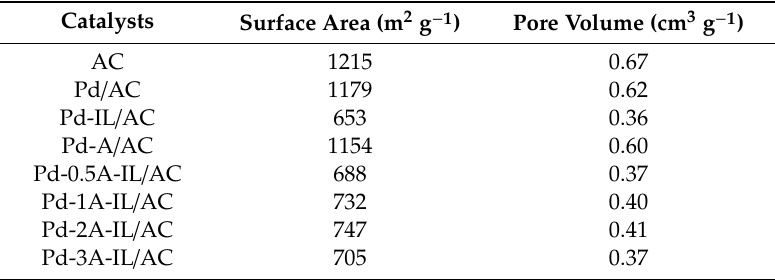
Figure 3. Characterization of fresh and used Pd-A-IL / AC catalysts. ( a ) XRD patterns. ( b ) XPS spectra. HAADF-STEM and EDS Mappings of ( c ) fresh and ( d ) used Pd-2A-IL / AC catalyst. Table 1. Pore structure parameters of